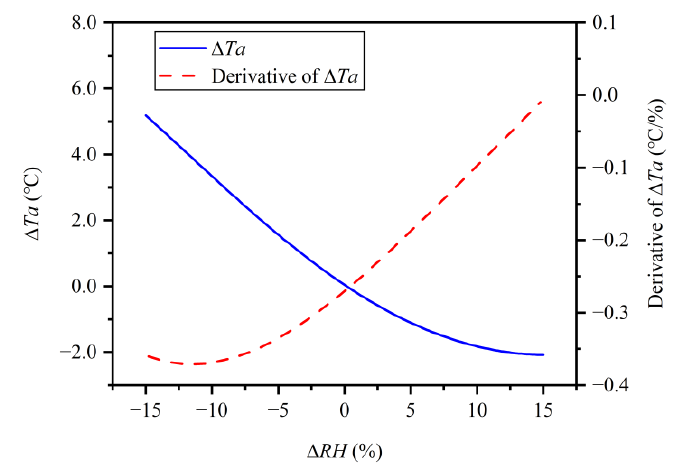
Figure 7. Air Temperature Difference (∆ Ta ) varying with Relative Humidity Difference (∆ RH ) at ∆ X = 0.